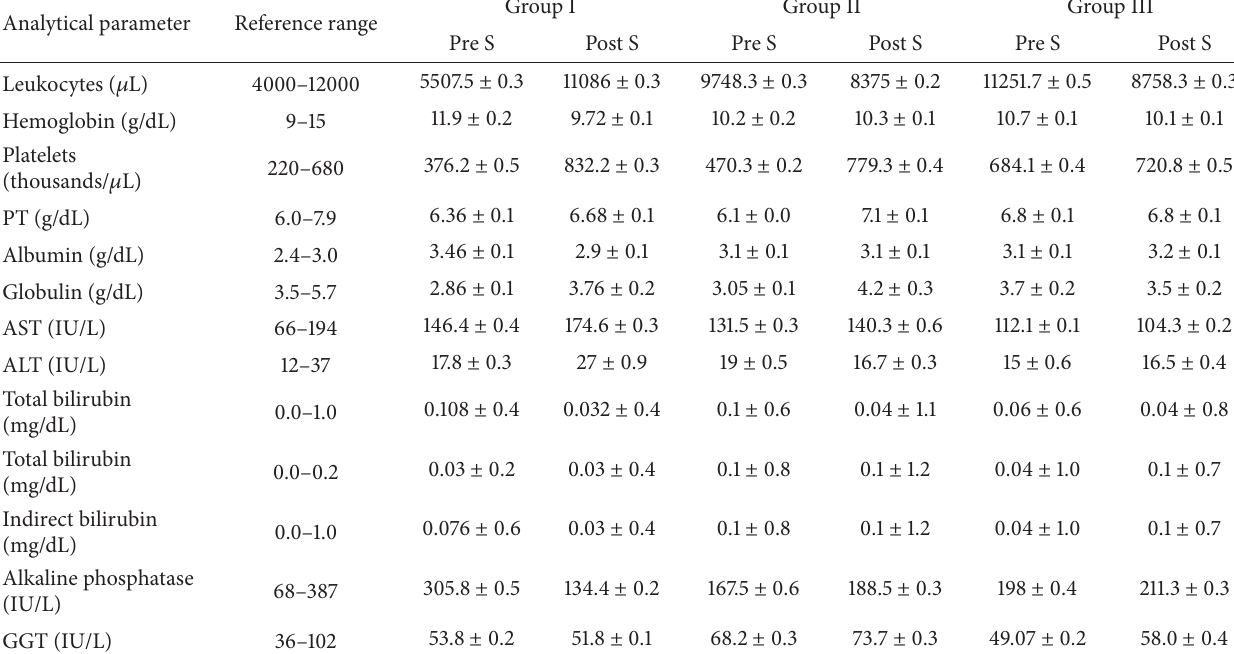
Table 1: Toxicity studies related to the use of adenoviral vectors.